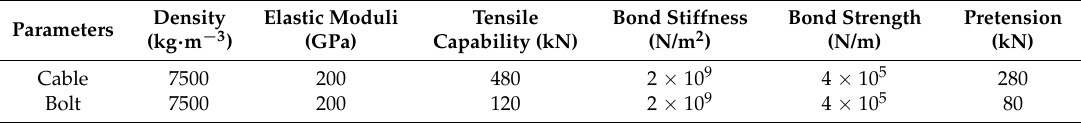
Table 5. Properties of the structure element in the UDEC.